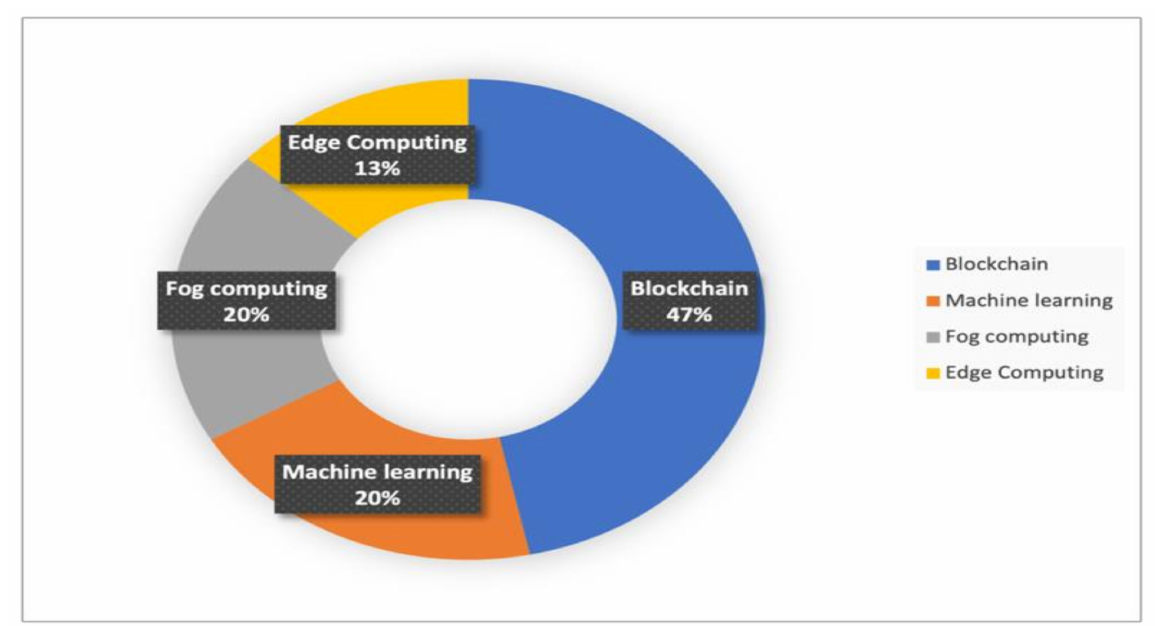
Figure 10. Common technologies used as a countermeasure for IoT